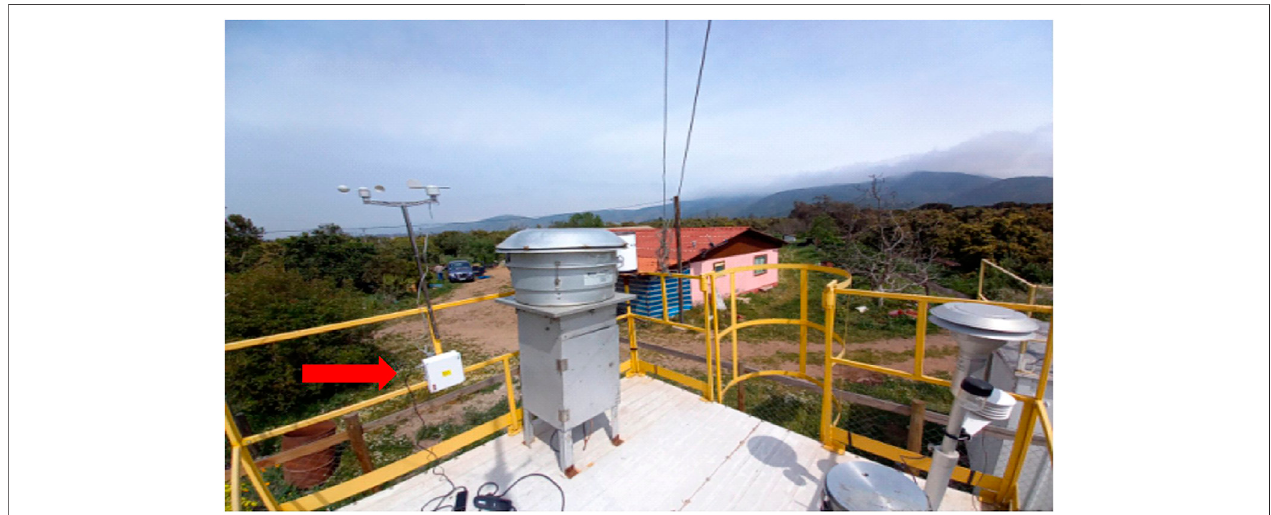
FIGURE 3 | Low cost monitoring station in Los Caleos (arrow). To the right is the sample inlet for the BAM-1020 monitor.